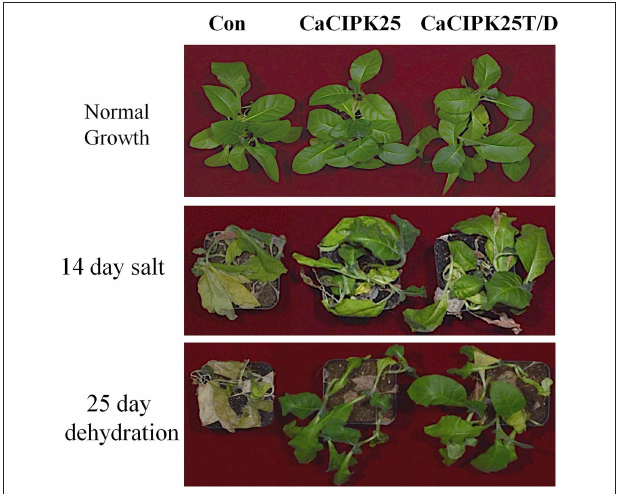
FIGURE 8 | Effect of salt on transgenic tobacco plants. Fifty-day-old soil-grown vector-control, CaCIPK25- and CaCIPK25T/D- overexpressing tobacco plants (top) were irrigated with 300mM sodium chloride for 2 weeks (middle) or, not irrigated with water for 25 days (bottom)